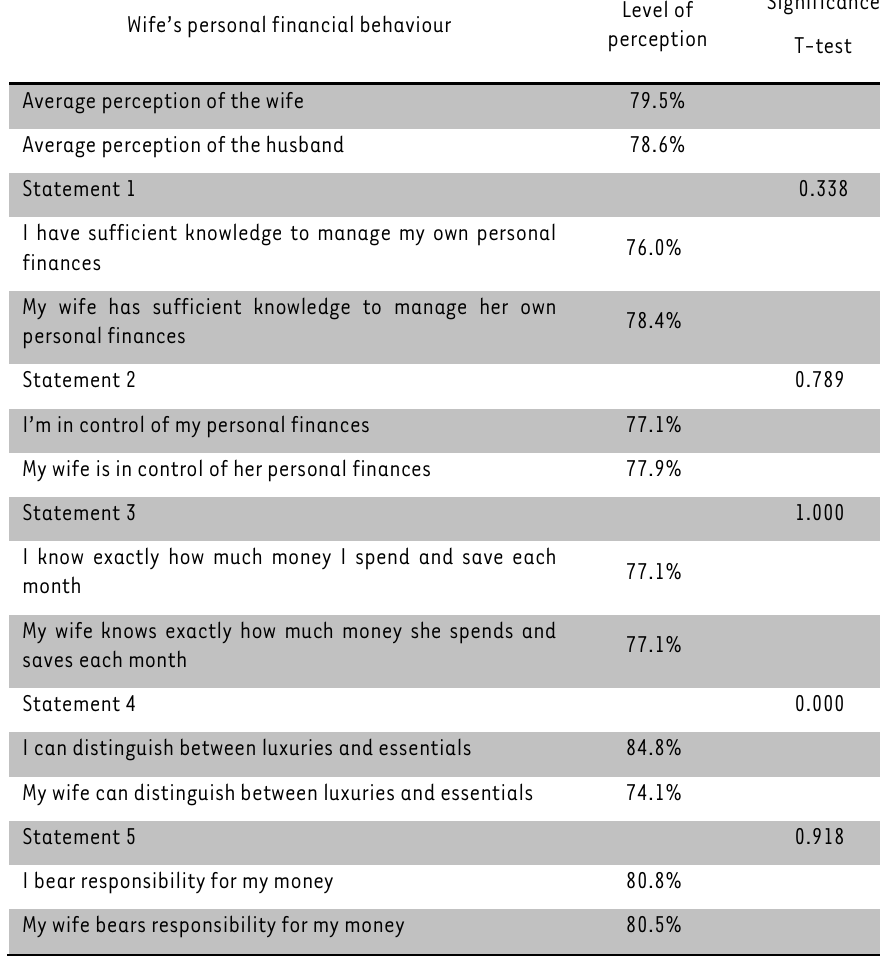
TABLE 3: Perception of men and women about the wife’s financial